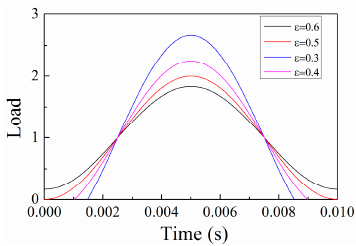
Figure 7. The effect of load distribution factor on vibration waveform.